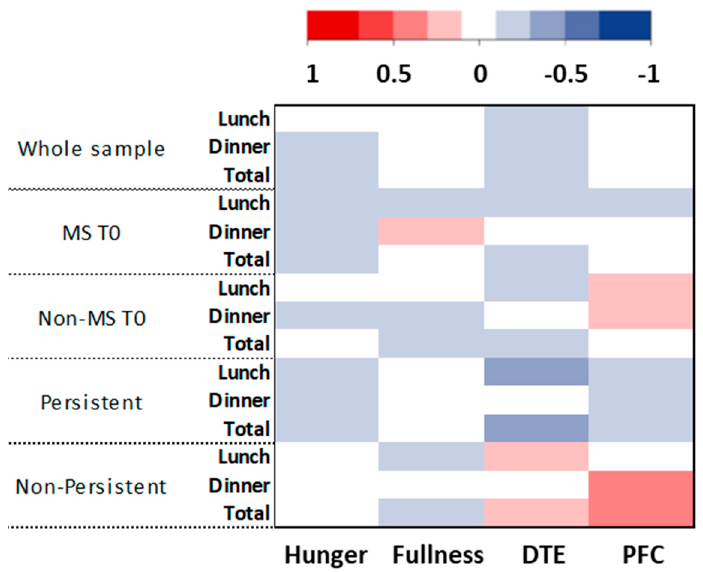
Figure 3. HeatMap representation of the correlations between the baseline and T1 changes of lunch, dinner, and total energy intake and changes of fasting hunger, fullness, desire to eat (DTE), and prospective food consumption (PFC). MS T0: adolescents with the metabolic syndrome at baseline; Non ‐ MS T0: adolescents without the metabolic syndrome at